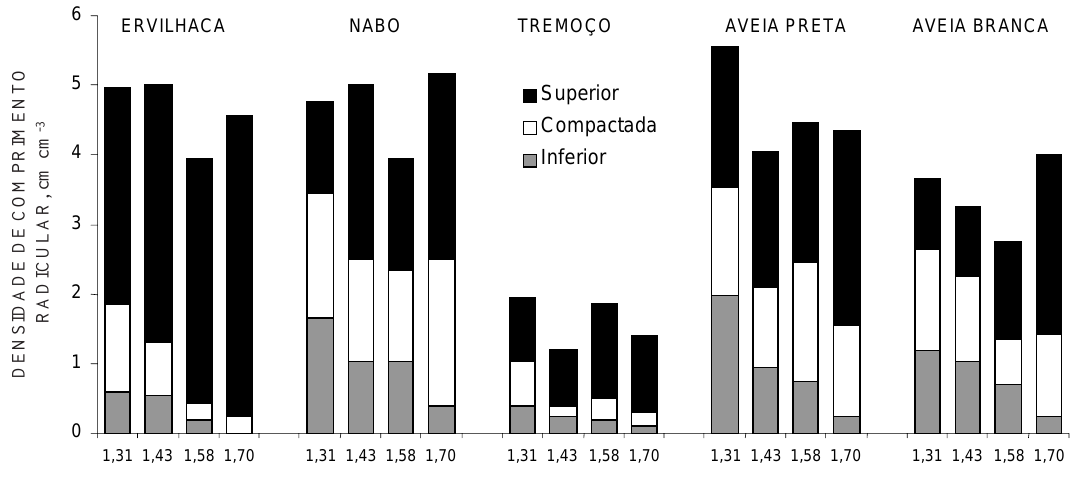
Figura 2. Distribuição da densidade de comprimento radicular das plantas de adubo-verde de inverno nas camadas dos vasos, considerando as densidades do solo na camada compactada.